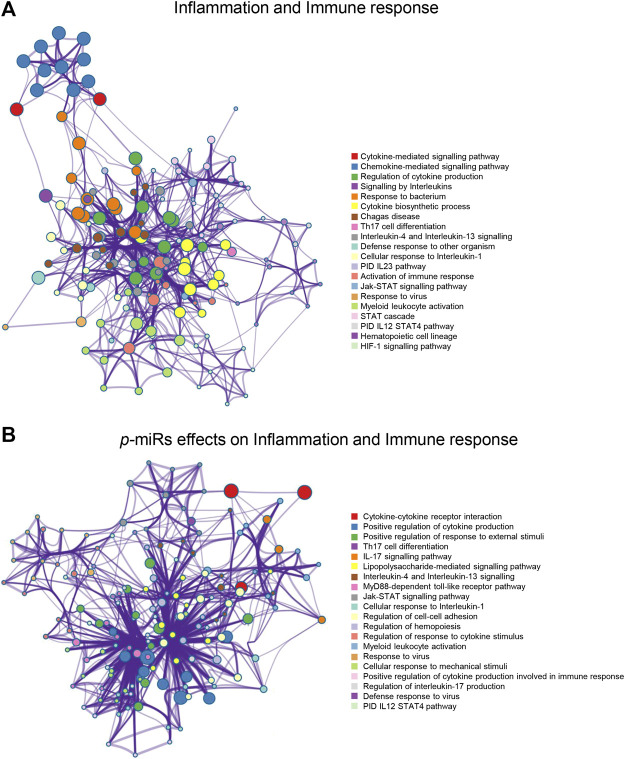
Enrichment network analysis for inflammation and immune response. (A) Networks layout of the clusters generated with the list of the genes associated with the inflammation and immune responses. (B) Networks layout of the clusters generated with the list of the genes regulated by p-miRs. Each circle node represents one enriched term, where its size is proportional to the number of input genes falling into that term, and its color represents its cluster identity (i.e. nodes of the same color belong to the same cluster). All similar terms with a Kappa similarity score >0.3 are connected by edges (the thicker the edge higher the similarity). One term from each cluster has been as a label. Created by Metascape [http://metascape.org].